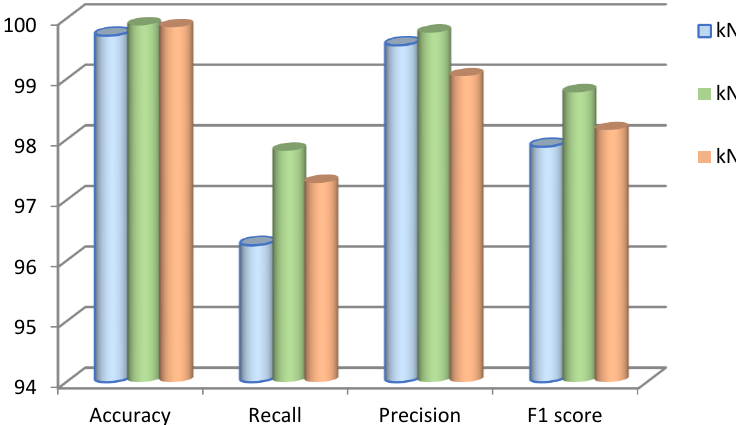
Figure 13. Level of accuracy, recall, precision and F1 score.